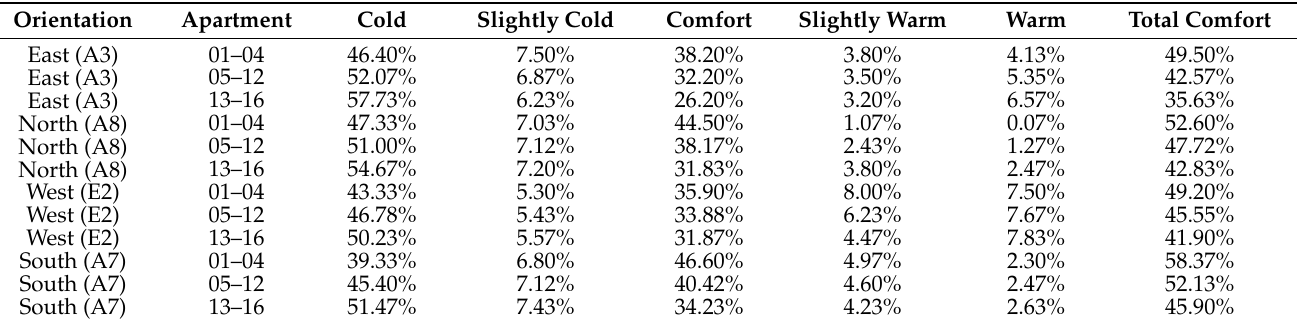
Table A6. Percentage of time in different thermal situations of the spaces by apartment, floor, and